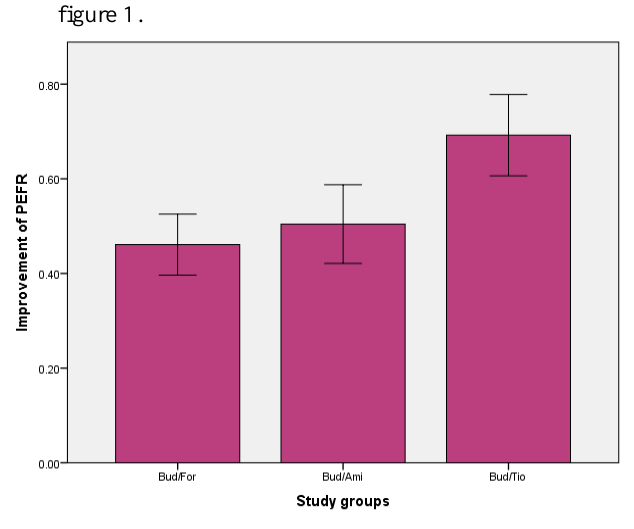
Figure 1. Comparison of groups according to extent of PEFR change during the first four weeks of study.